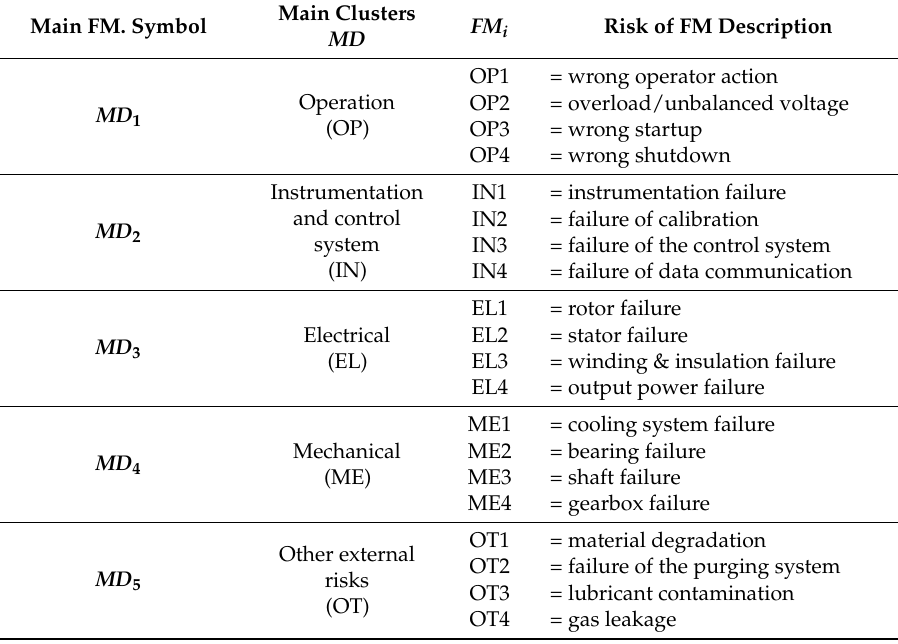
Table 1. Main risk clusters and failure modes.